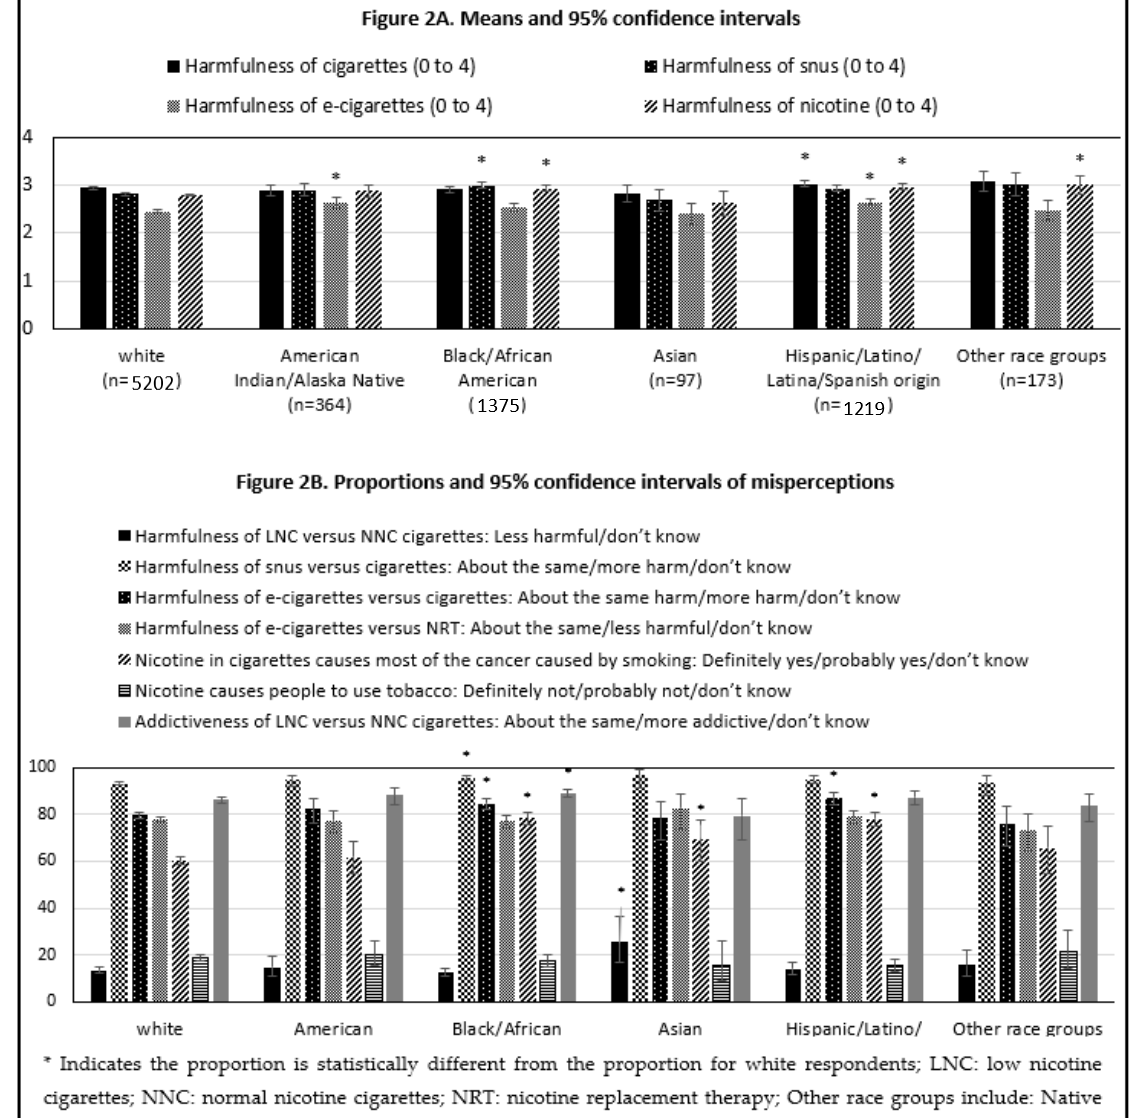
Figure 2. Means or proportions and 95% confidence intervals for response categories. Persons who currently smoke daily or some days by race/ethnicity. ( A ) displays the perceived harm of products by racial and ethnic groups; ( B ) displays the proportion of respondents endorsing a misperception about nicotine or the relative risks of products by racial and ethnic group.